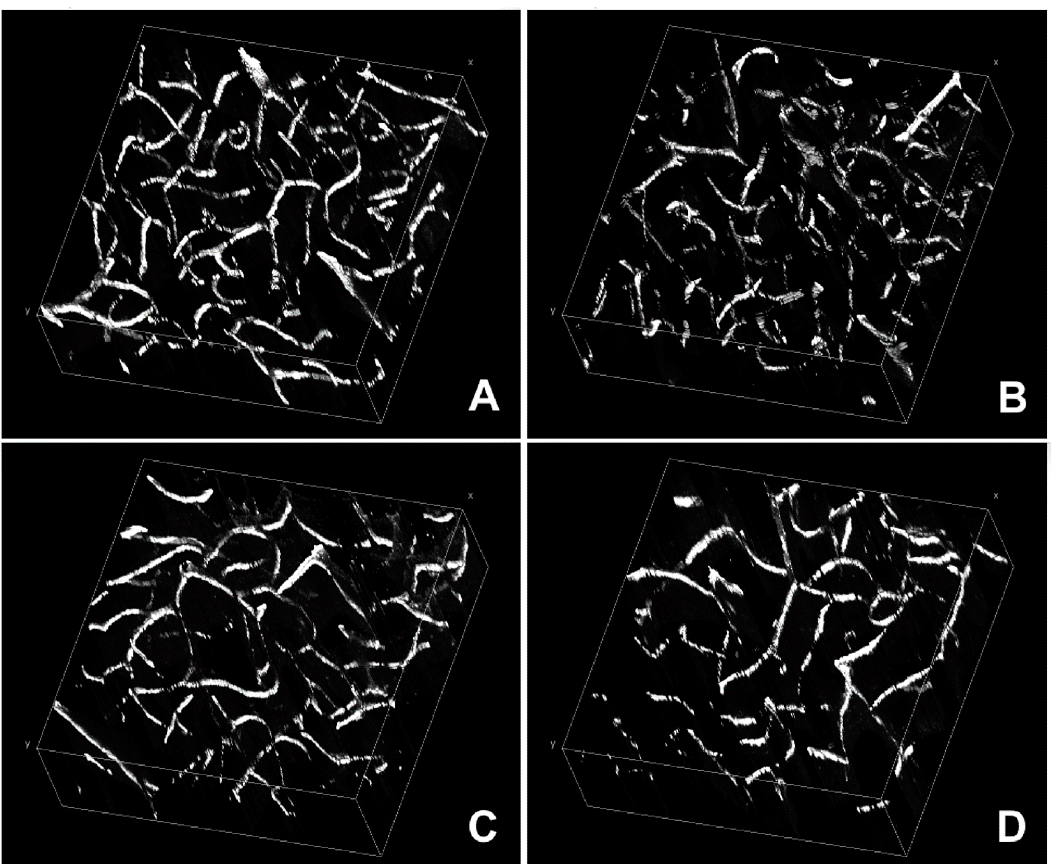
Figure 1. Renderings of brain cortex microvascular angioarchitectures. Image stacks acquired from CD31-immunostained samples of the prefrontal cortex of wild-type (wt) ( A , B ) and twitcher (twi) ( C , D ) mice were made isotropic and visualized with the ImageJ plugin Volume viewer. In the latter images, it is possible to appreciate the reduced complexity of the overall angioarchitecture.